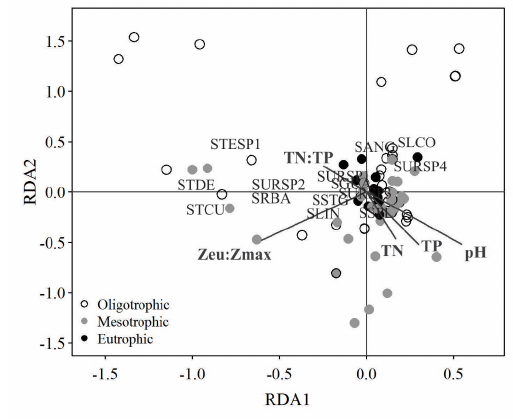
Figure 2. Results of partial RDA for the 14 Surirellales species from surface sediments. Environment variables codes are available in Table 1 and species codes in Table